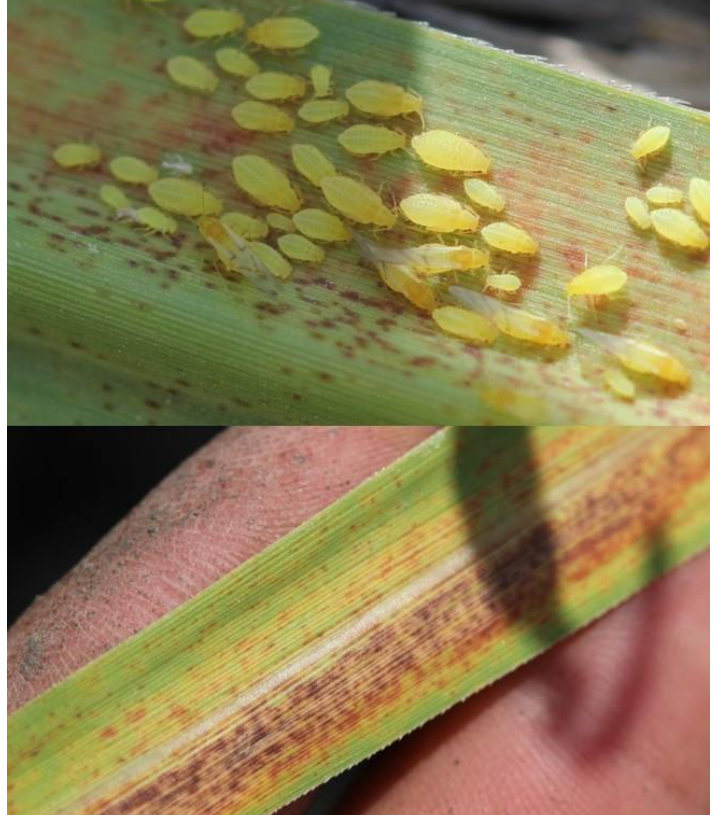
Figure 2. Yellow sugarcane aphid, Sipha flava , nymphs, adults, and alates (top); and reddening/yellowing of sugarcane leaves caused by S. flava feeding (bottom) . Photos: © B.E. Wilson.